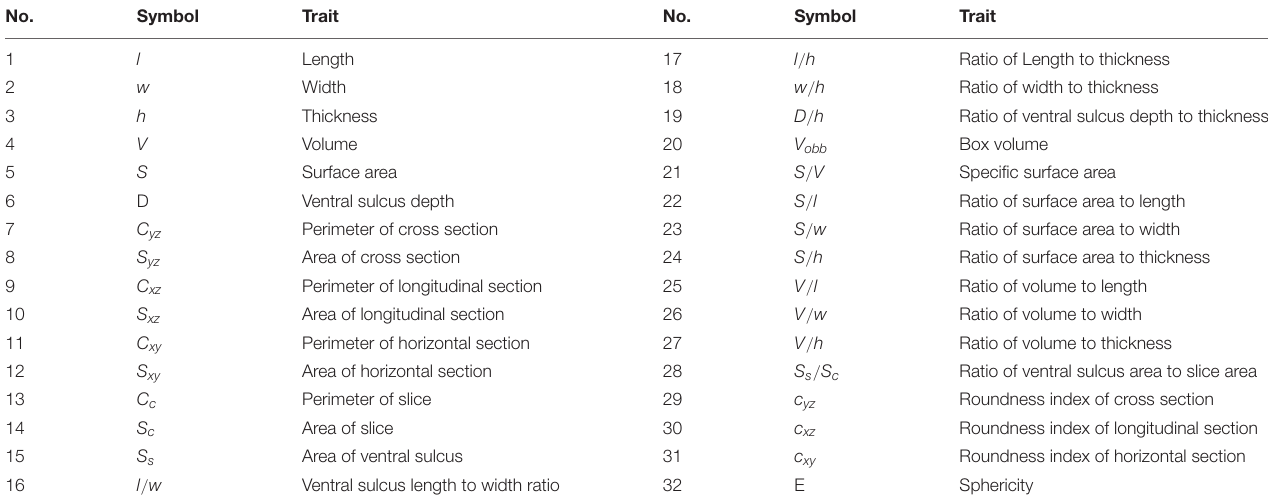
TABLE 2 | The extracted 32 phenotypic traits of wheat grain. No. Symbol Trait No. Symbol